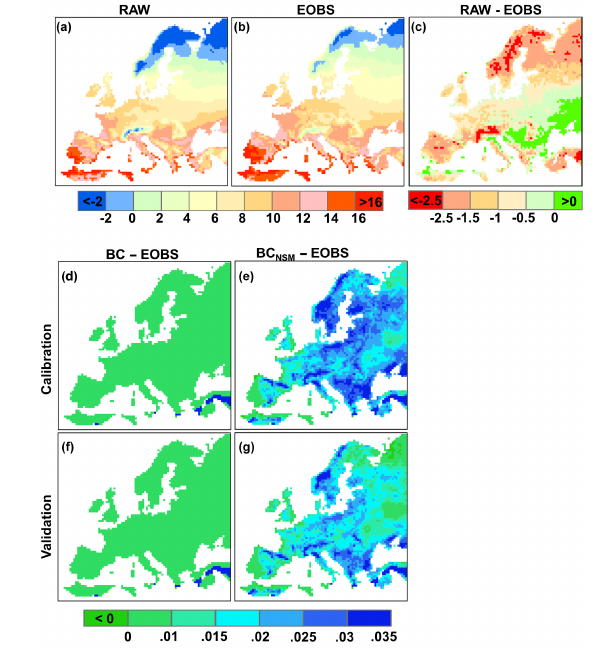
Figure 7. Mean surface temperature of the cross validation test. Panels (a) and (b) show the ensemble mean of the five raw models data and the EOBS respectively, while panel (c) shows their differ- ence. Panels (d) and (e) show the ensemble mean remaining bias of the five RCMs after the correction with and without the NM module respectively, for the calibration periods’ data. Panels (f) and (g) are the same as (d) and (e) but for the validation period data.